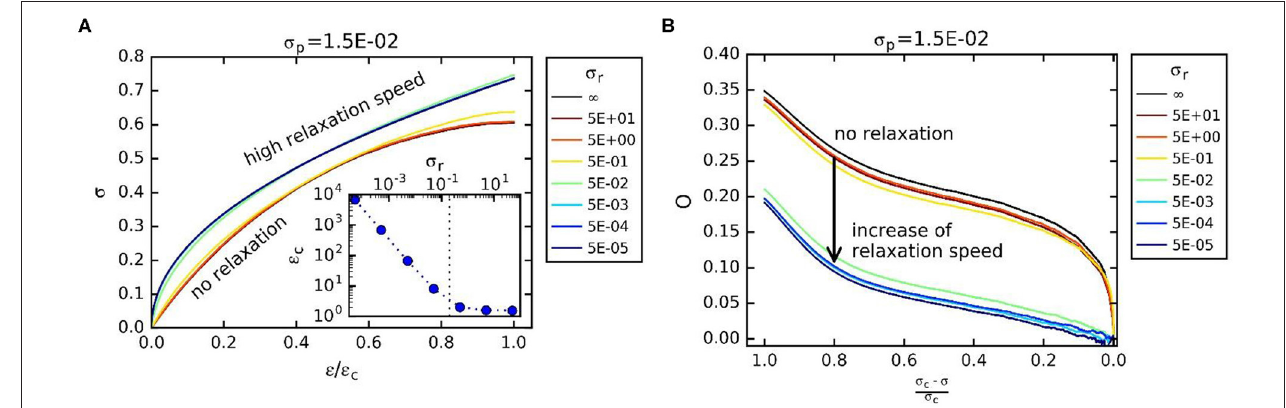
FIGURE 7 | (A) Stress-strain relations of FBM for different relaxation characteristic loads σ r and a constant sintering characteristic load σ p = 1.5 × 10 − 2 . The strain was scaled with the strain at failure ǫ c . The inset shows the strain at failure ǫ c as a function of the relaxation characteristic load σ r . (B) Evolution of the order parameter O toward failure for different σ r and constant σ p = 1.5 × 10 − 2 . The characteristic times t r/p were scaled to characteristic loads with σ r / p = ˙ σ t r / p . Reprinted from [5].